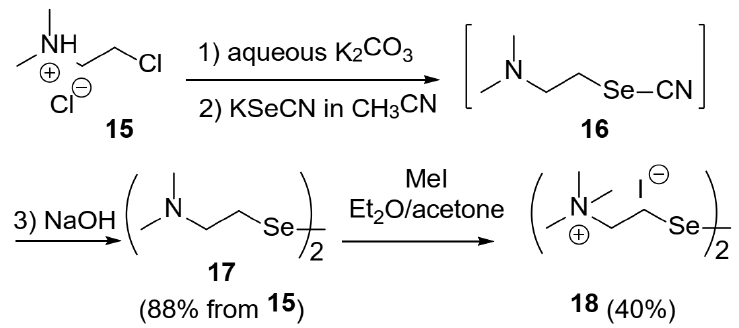
Scheme 1. Synthesis of diselenide precatalysts 17 and 18